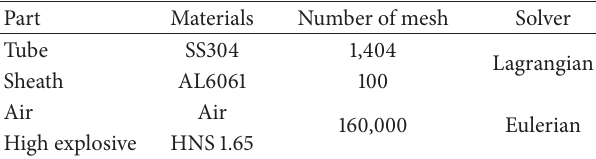
Table 2: Steinberg-Guinan strength parameters.